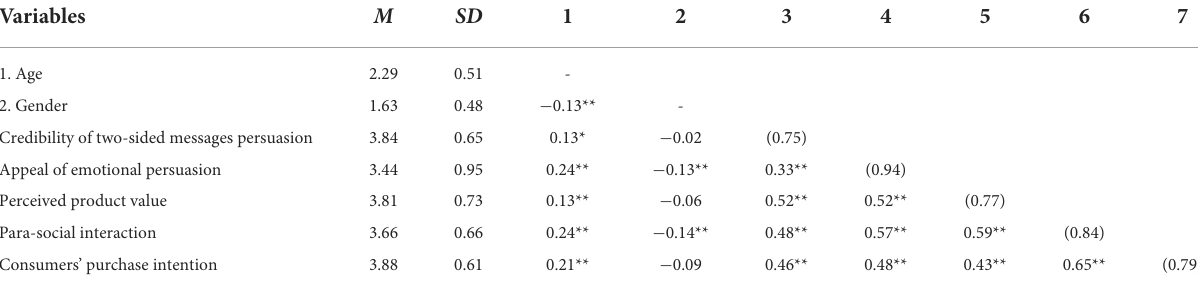
TABLE 2 Means, standard deviations, and correlations of the focal variables in study ( N = 511).